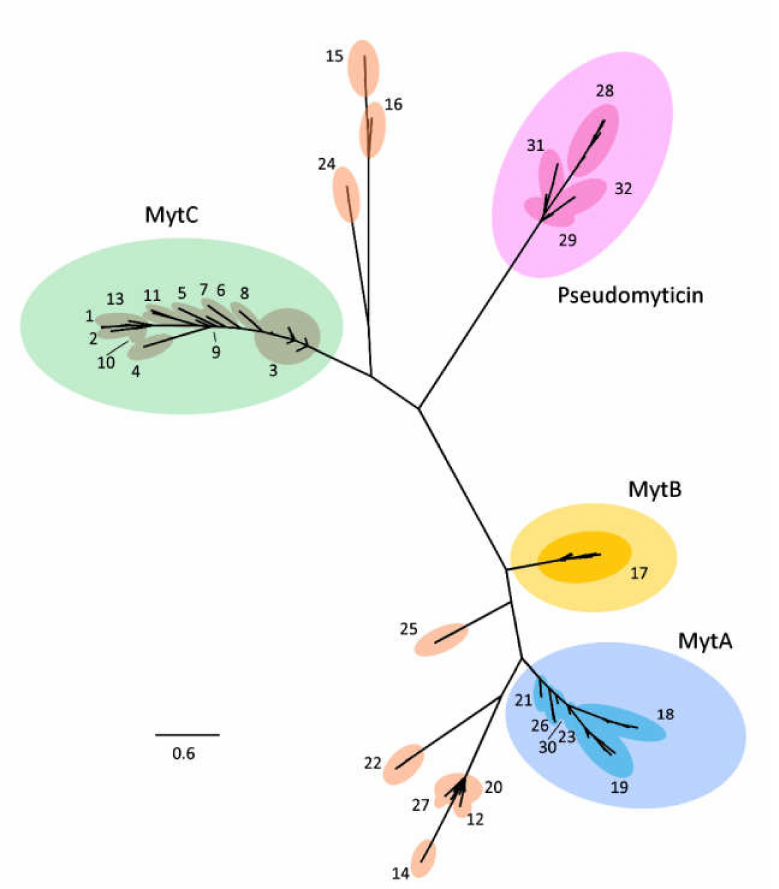
Figure 1. Phylogenetic analysis. Exon 3 of 120 myticin sequences obtained from 16 genomes were subjected to multiple sequence alignment and analyzed with Bayesian phylogenetic inference. The employed evolution model was the Jukes and Cantor model (JC). Numbers at termini correspond to the 32 major groups found by CD-HIT (based on a pairwise sequence identity > 95%). Green (MytC), yellow (MytB), blue (MytA), and purple (pseudomyticin) ellipses indicate the variants falling